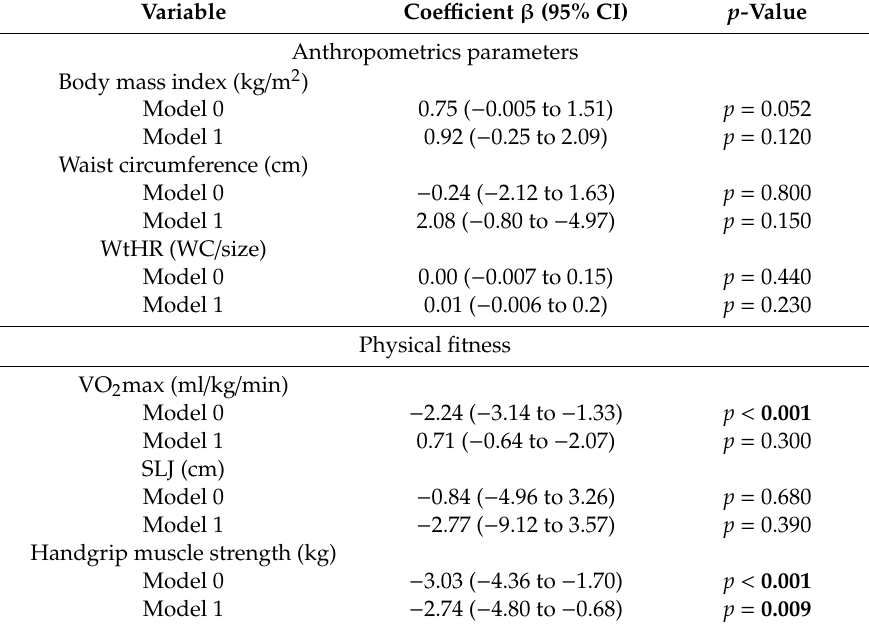
Table 4. Association between ethnic ascendant presence with anthropometrics’ parameters, physical fitness and